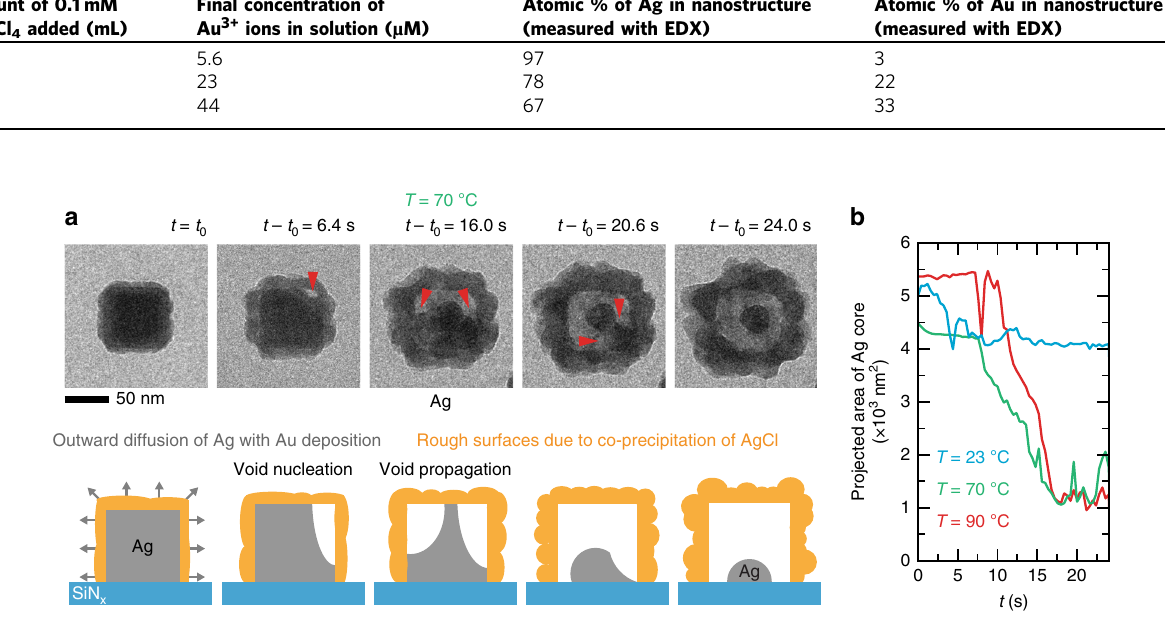
(Fig. 1a: t − t 0 = 4.0 s) and 90 °C (Fig. 1b: t − t 0 = 9.6 to t − t 0 = 13.6 s). Third, in the in situ experiments, the reaction